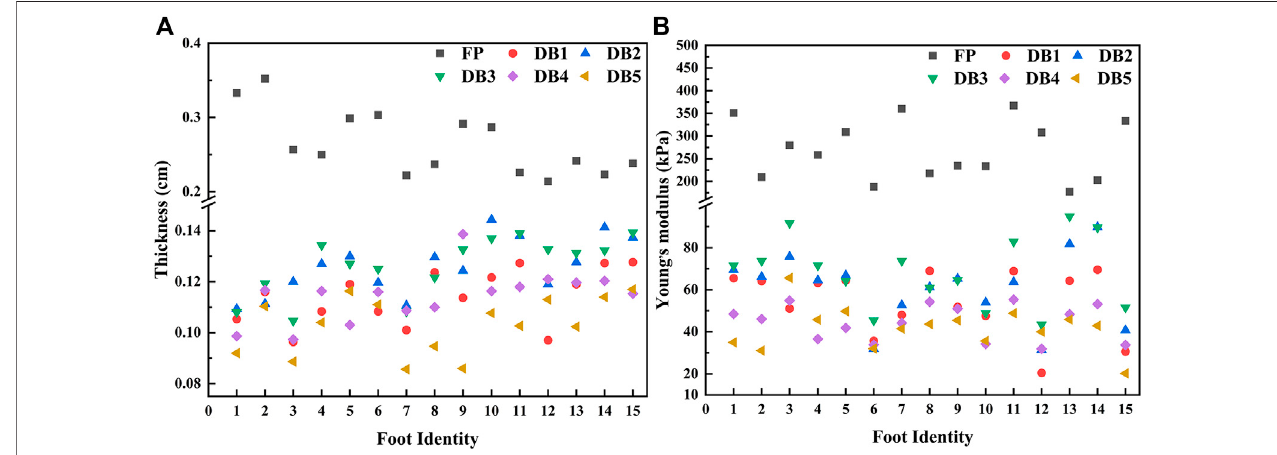
FIGURE 6 | Distribution of plantar fascia thickness (A) and Young ’ s modulus (B) at proximal fascia (PF) and the fi ve distal branches in 15 fl atfeet.